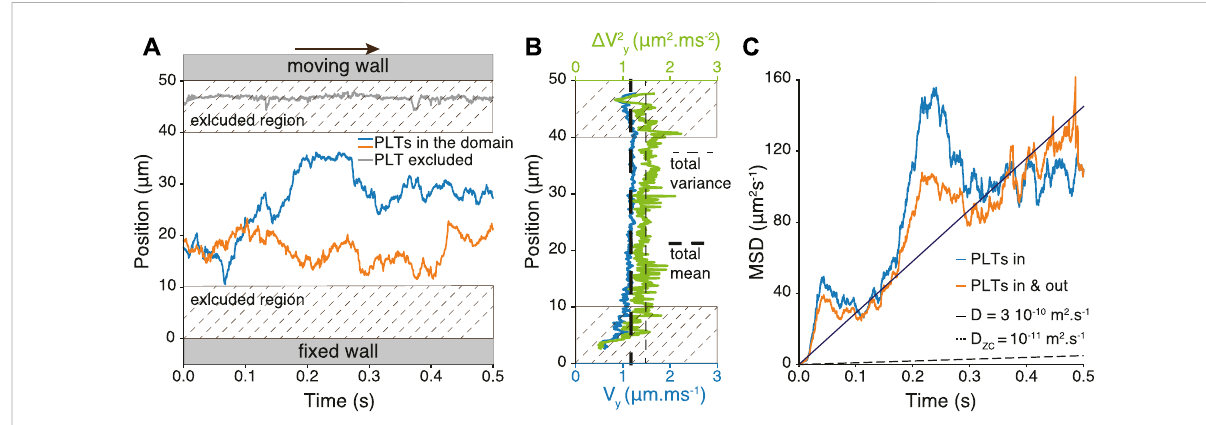
FIGURE 2 (A) Sketch of the system with the region in which platelets trajectories are recorded. Trajectories y ( t ) of two representative platelets along the direction perpendicular to the fl ow. Platelets (gray) with trajectory inside the excluded region are not considered for analysis. The situation shown in this fi gure corresponds to a wall to wall distance of L = 50 μ m , hematocrit H = 0.35 and shear rate _ γ (cid:1) 100 s − 1 . (B) Pro fi les of the velocity V y (blue) and the variance of the velocity Δ V 2 y (green) along the wall direction y. Velocity and its variance are computed in bins of 0.1 μ m and bins with frequency lower than 0.1% are not represented. The total mean (resp. variance) in thick (resp. thin) dashed line is computed away from the wall (between y = 10 μ m and y = 40 μ m ). (C) The mean square displacement MSD( t ) measured within the system limits is shown, as well as the corresponding diffusion coef fi cient. The blue curve represents the MSD measured from the platelets that remain in the domain of interest during all the simulation time (in), while orange curve is computed from the trajectories of the platelets during their residency in the domain (in and out). The dashed straight line represents the MSD expected by Zydney-Colton theory.